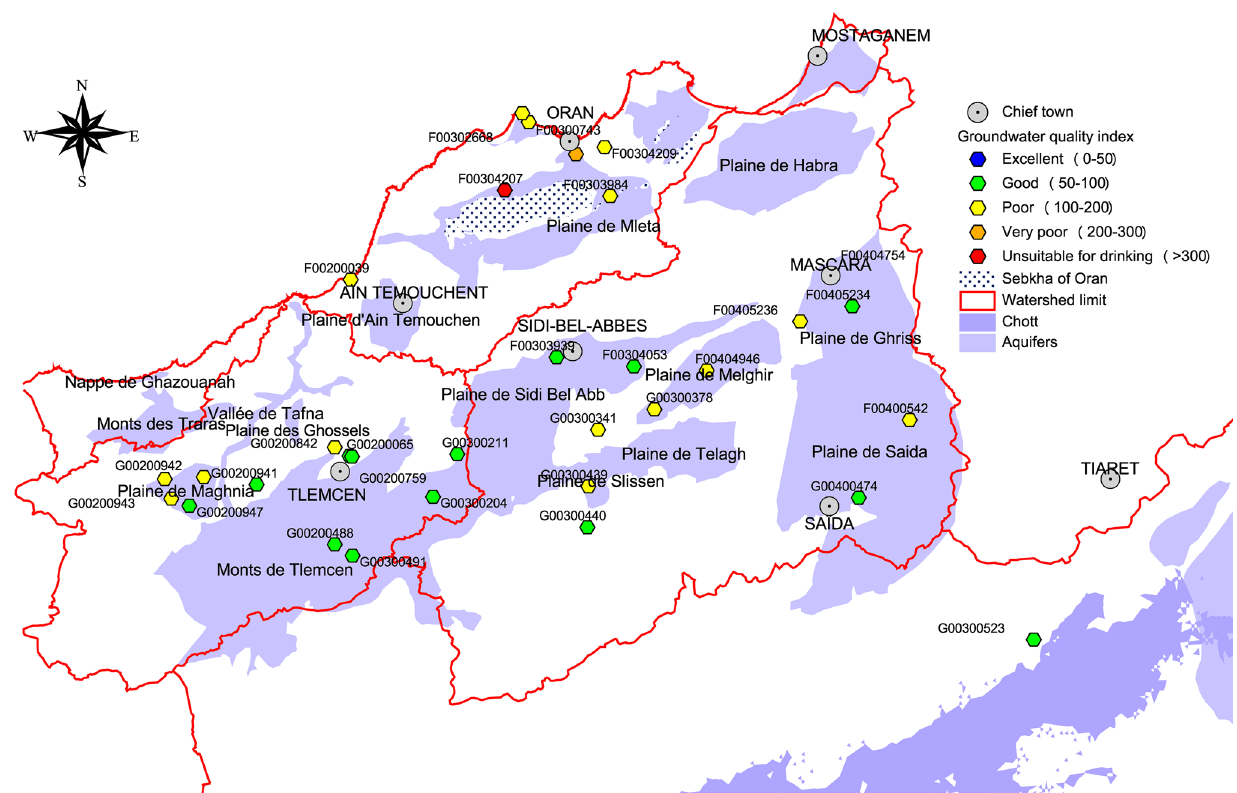
Fig. 4 Spatial map for groundwater quality index in Northwestern Algeria for the year 2005